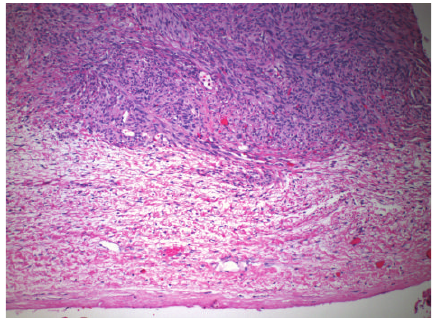
Figure 4: Histology: intact capsule